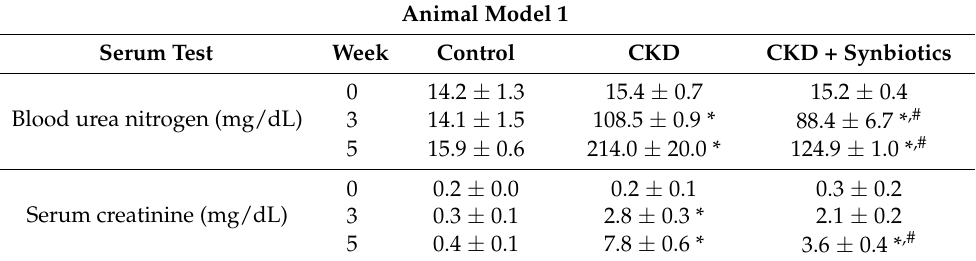
Figure 5. The body weight changes in animal model 1. The bodyweight of the controls ( • ), CKD rats ( (cid:4) ), and synbiotics-treated CKD rats ( (cid:78) ). A significant difference between the controls vs. CKD group vs. synbiotics-treated CKD group was analyzed using ANOVA. *, p < 0.05. n = 6 for each group. Table 3. The blood test of animal model 1. The blood urea nitrogen (BUN) and serum creatinine changes in the controls, CKD rats, and synbiotics-treated CKD rats. All data were presented as means ± SEM. A significant difference between the controls vs. CKD group vs. synbiotics-treated CKD group was analyzed using ANOVA. *, p < 0.05. n = 6 for each group. A significant difference between the CKD group vs. the synbiotics-treated CKD group was analyzed using ANOVA. #, p < 0.05. Abbreviation: CKD, chronic kidney